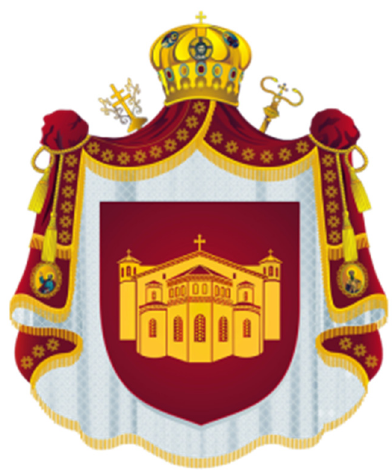
Figure 25. Coat of arms of the Macedonian Orthodox Church—Archbishopric of Ohrid.